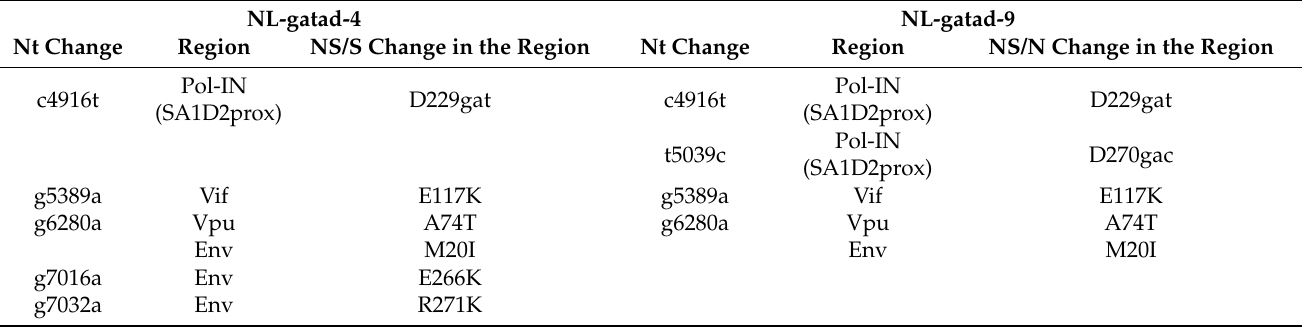
Table 2. Mutations found in adapted clones that exhibit higher Vif expression levels than that in the NL-D229gat clone. NL-Gatad-1 NL-Gatad-6